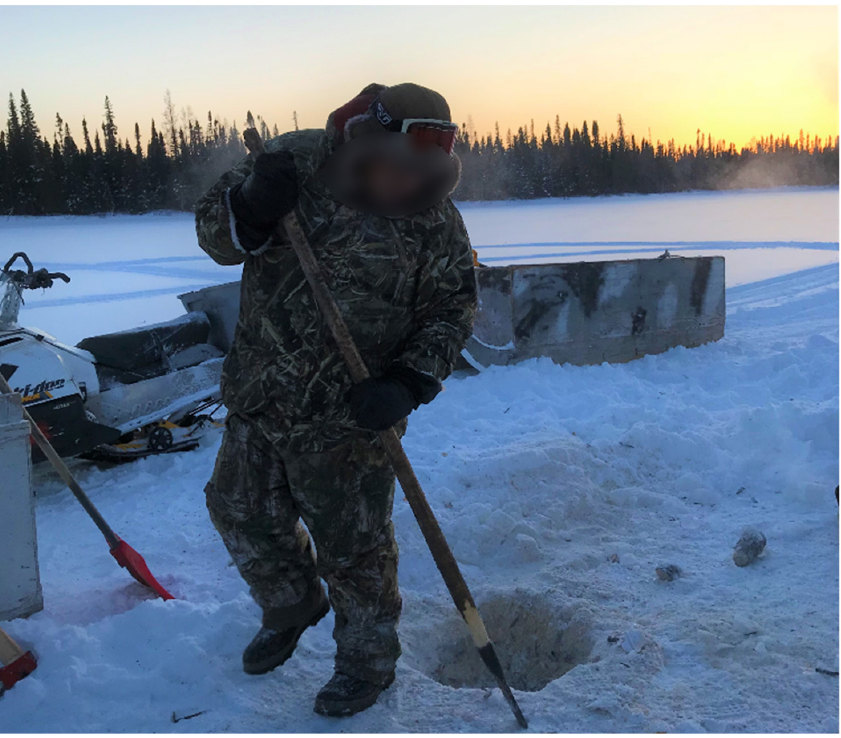
Figure 5. An on-the-land expert using a tool to help clear the ice to set beaver traps.